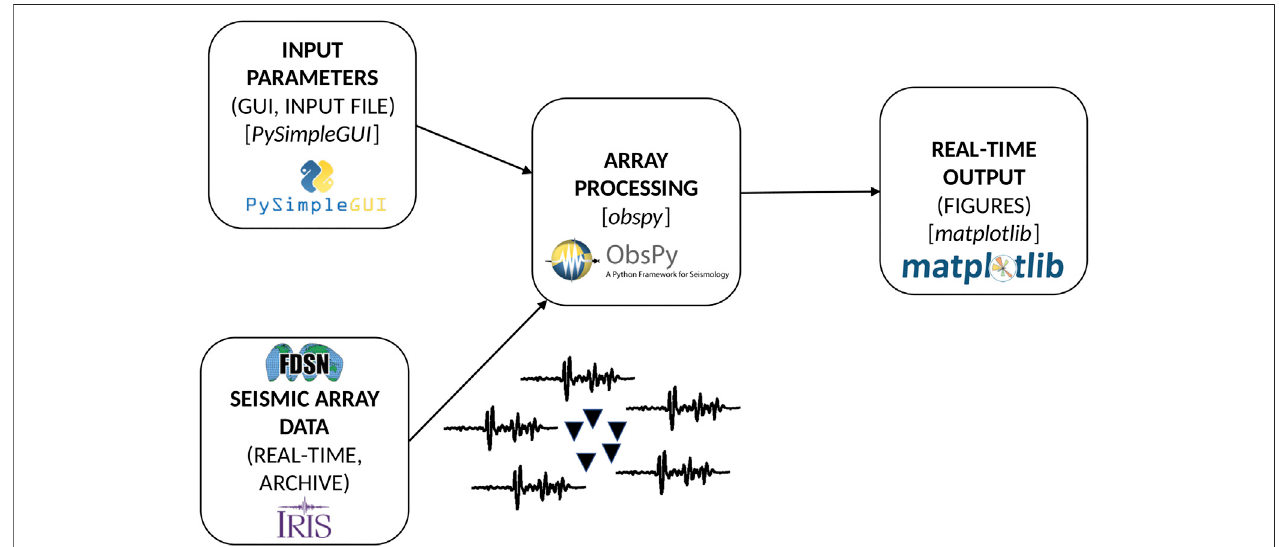
FIGURE 1| Schematic overview ofthe RETREAT software package. Input parameters and con fi guration are collected from the GUI or web interface that wasbuilt using thePySimpleGUI module. Next,thesesettings allowseismicarraydata(real-time datafromexternalsources, e.g.IRISoranyotherserver,orexisting archivedata) tobeprocessed andanalyzed using thestandard arrayprocessingroutinesinObsPy.Output fi guresdisplayingtheresultsofthearrayanalysisarethenproduced using the matplotlib python module and are continuously updated as new data is processed.